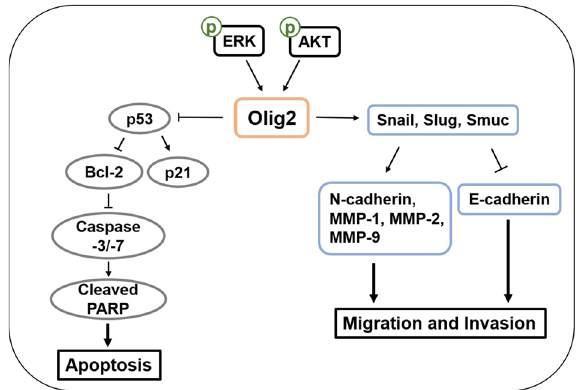
Figure 9. Olig2 regulates apoptosis, migration and invasion of melanoma cells. Both PI3K and MAPK pathways are involved in the regulation of Olig2 in melanoma cells. Inhibition of Olig2 induces p53 apoptosis pathway, then decreases viability of melanoma cells. Olig2 regulates EMT transcription factors such as snail and slug, and subsequently E-cadherin, N-cadherin and MMPs. Down regulation of Olig2 suppressed migration and invasion of melanoma